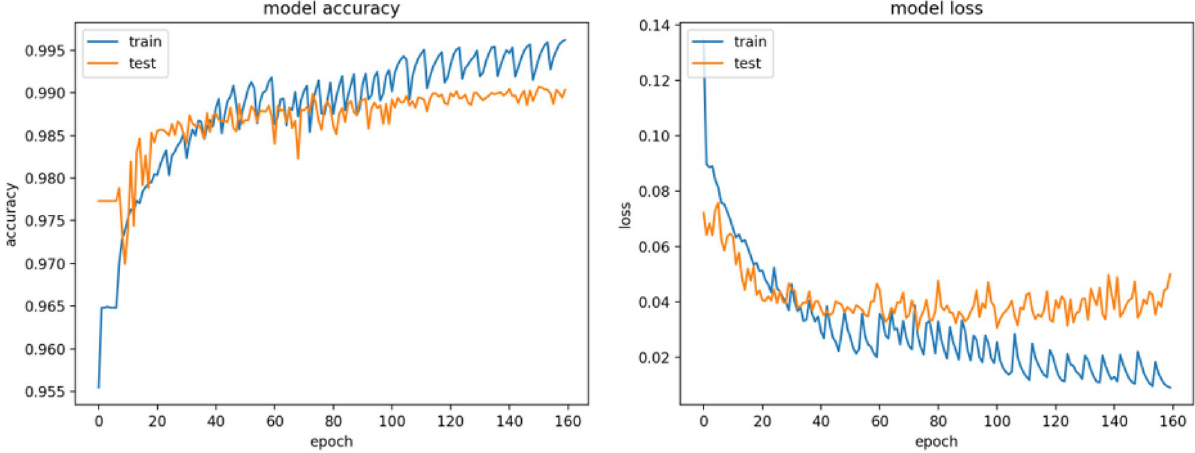
Figure 6. Accuracy and loss values throughout the learning process. x-axis show the number of epochs, y-axis show accuracy and loss values